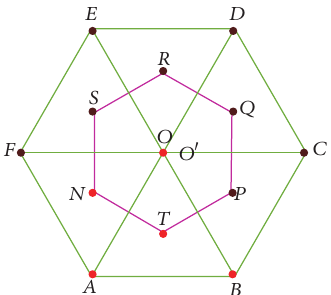
Figure 9: The detailed wood defect’s measurement